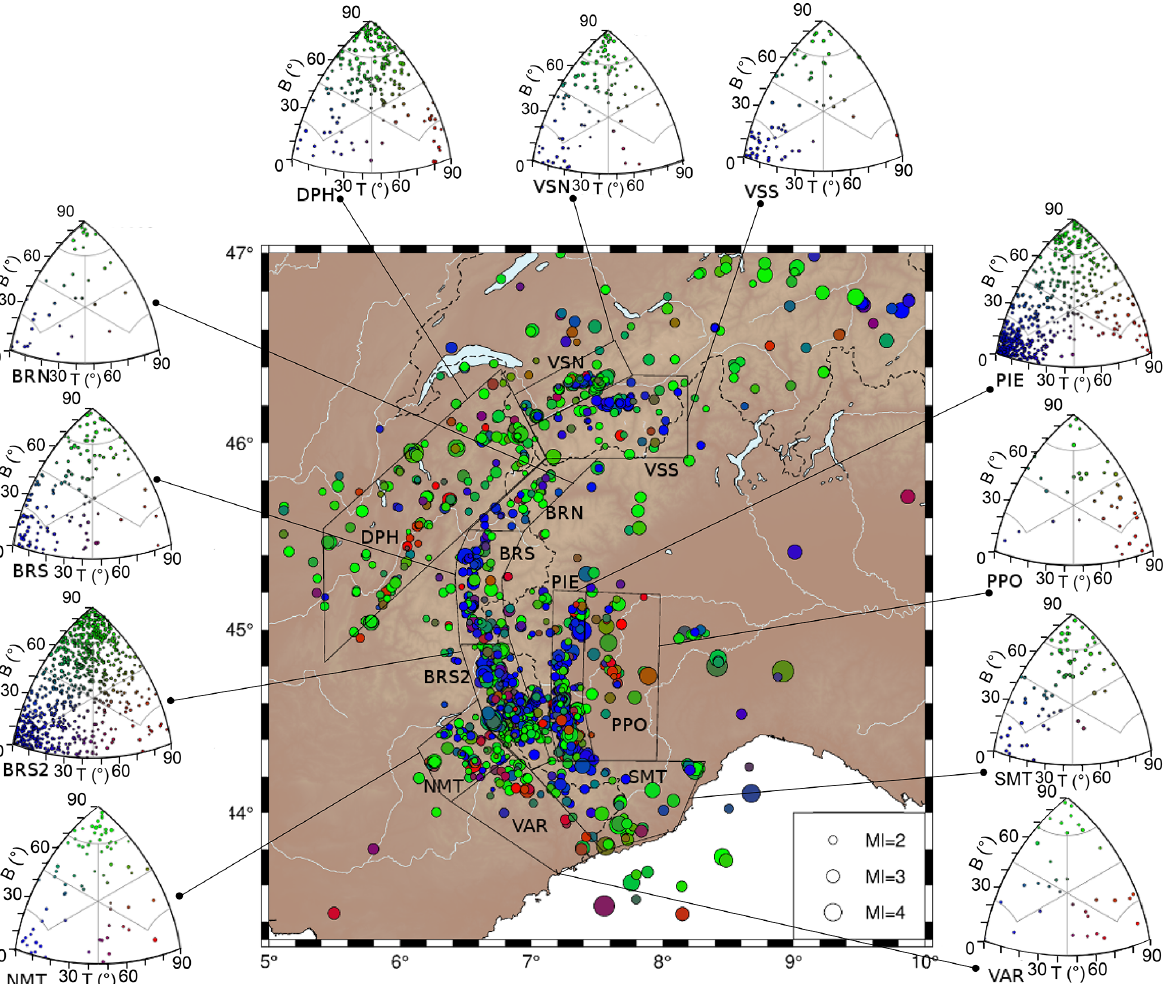
Figure 3. Seismotectonic zonation of the study area, yielding 11 zones based on structural criteria, style of seismic deformation, and density. VSS stands for Valais south, VSN stands for Valais north, BRN stands for Briançon north, BRS stands for Briançon south, BRS2 stands for Briançon south 2, PIE stands for Piémontais seismic arc, PPO stands for Po plain, VAR represents Var; NMT stands for northern Mercantour, SMT stands for southern Mercantour, and DPH stands for Dauphinois zone. Kaverina diagrams are shown for each seismotectonic zone, highlighting their homogeneous style of deformation, associating either normal and strike-slip events or reverse and strike-slip